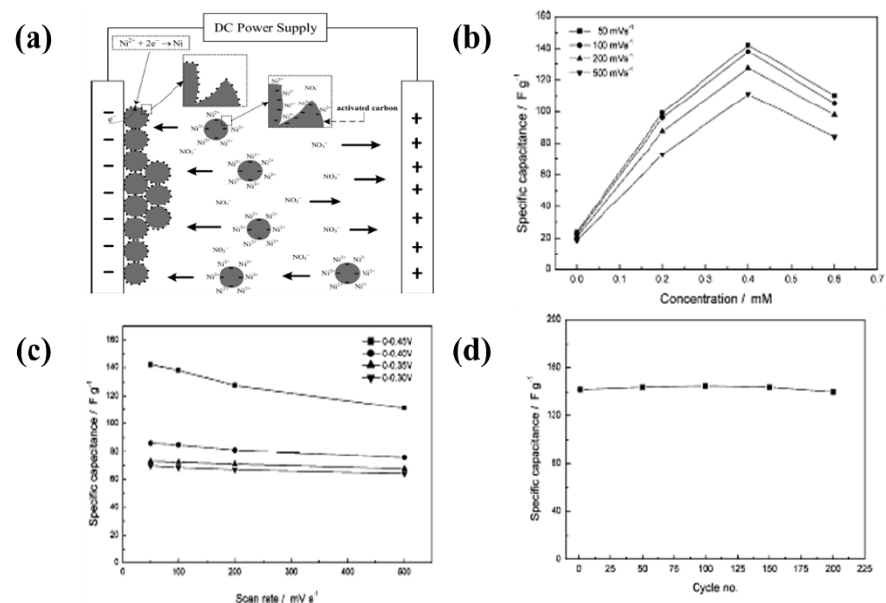
Figure 23. ( a ) Schematic diagram of the proposed Ni-decorated activated-carbon deposition in the EPD process; ( b ) Specific capacitance of Ni-decorated activated-carbon electrodes deposited with various concentrations of nickel nitrate; ( c ) Specific capacitance of a Ni-decorated activated-carbon electrode deposited at a concentration of 0.4 mM nickel nitrate; ( d ) Variation of the specific capacitance with the cycle number for the Ni-decorated activated-carbon electrode deposited using 0.4 mM nickel nitrate. Wu et al. reported the hybrid electrode of Ni/1,4-bezenedicarboxylic (BDC) powder carbonized at various temperatures prepared by EPD [247]. EPD was carried out at − 60 V for 10 s in a suspension containing Ni-BDC powder carbonized at 800 ◦ C and IPA. The hybrid electrode reached as much as 886 F · g − 1 at a discharge current density of 1 A · g − 1 that only decreased slightly to 746 F · g − 1 at 30 A · g − 1 in a 1 M KOH electrolyte. Lin et al. proposed a novel electrode structure of 3D-porous CNT network by an EPD-supported nickel oxide nanonet, as shown in Figure 24a [246]. They developed two processing approaches involving EPD of MWCNTs. In the first step, a 3D porous CNT film was deposited electrophoretically up to a mass loading of 0.22 mg at − 60 V and nickel oxide nanonet was then formed between the adjacent CNTs by hydrothermal synthesis. The well-dispersed nickel oxide nanonet provided a large faradaic capacitance of 1511 F · g − 1 at a high current density of 50 A · g − 1 as well as high capacitance retention of 92.4%, which was superior to that of the NiO electrode with the CNTs network (59%), as shown in Figure